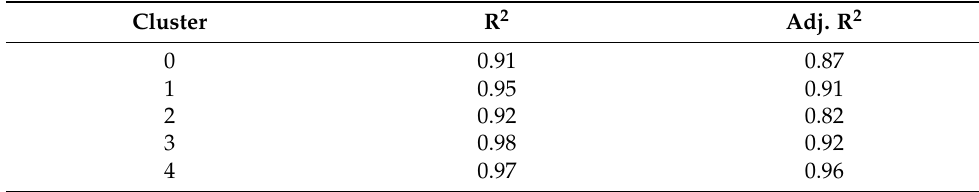
Table A1. Result of running with 5